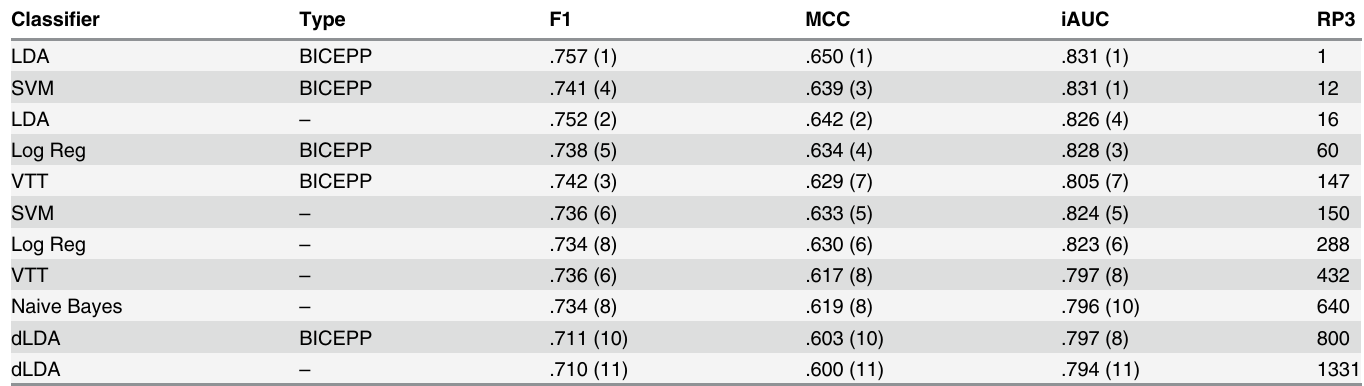
Table 6. Sentence classification performance with NER features. Performance of different sentence classifiers with the count features obtained via the BICEPP NER tool; also listed are the corresponding best classifiers using only textual features (bigram runs; indicated by -). F1, MCC, and iAUC performance measures are listed; the rank of the classifiers according to each measure is reported in parenthesis in the respective column. Classifiers are ordered accord- ing to the rank product (RP3) of the three measures (last